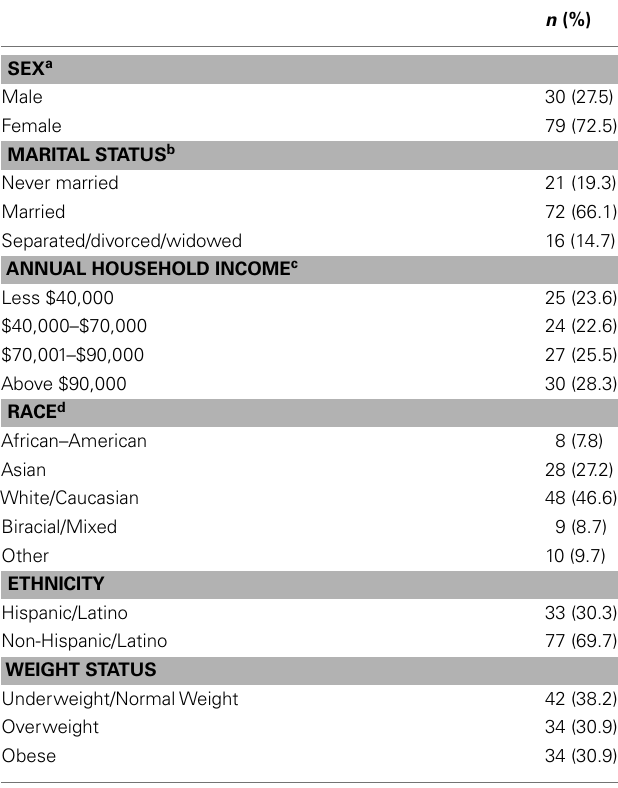
Table 1 | Participant